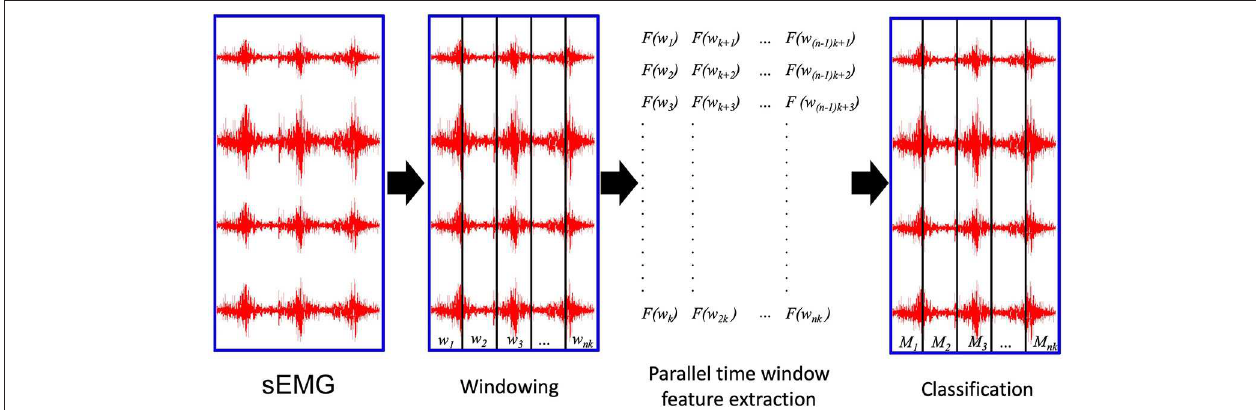
FIGURE 1 | The parallel time window feature extraction: w i are the time windows to be analyzed; k is the number of parallel threads used to compute the signal features. nk is the total number of time windows; M i are the movements classified according to the extracted signal